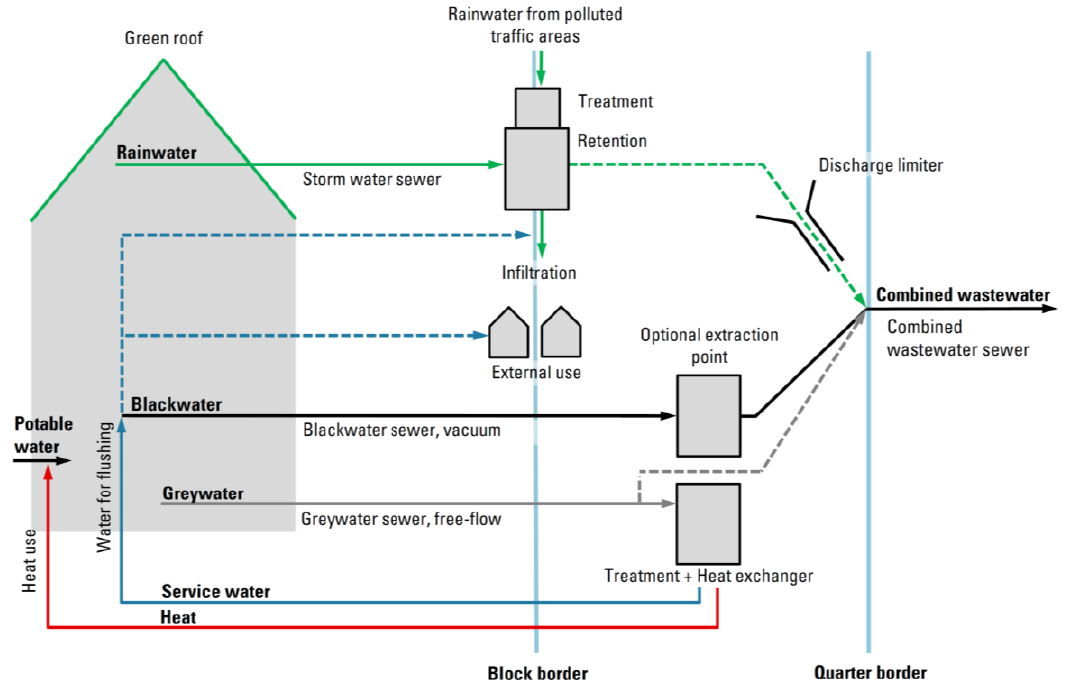
Figure 2. Scheme of the ConvGrey Hamburg technical option at the quarter level (based on [31]).